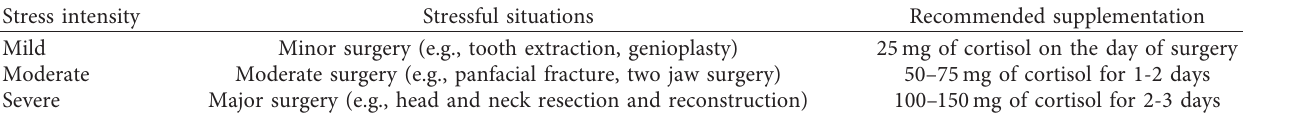
Table 4: Corticosteroids supplementation protocol in stressful